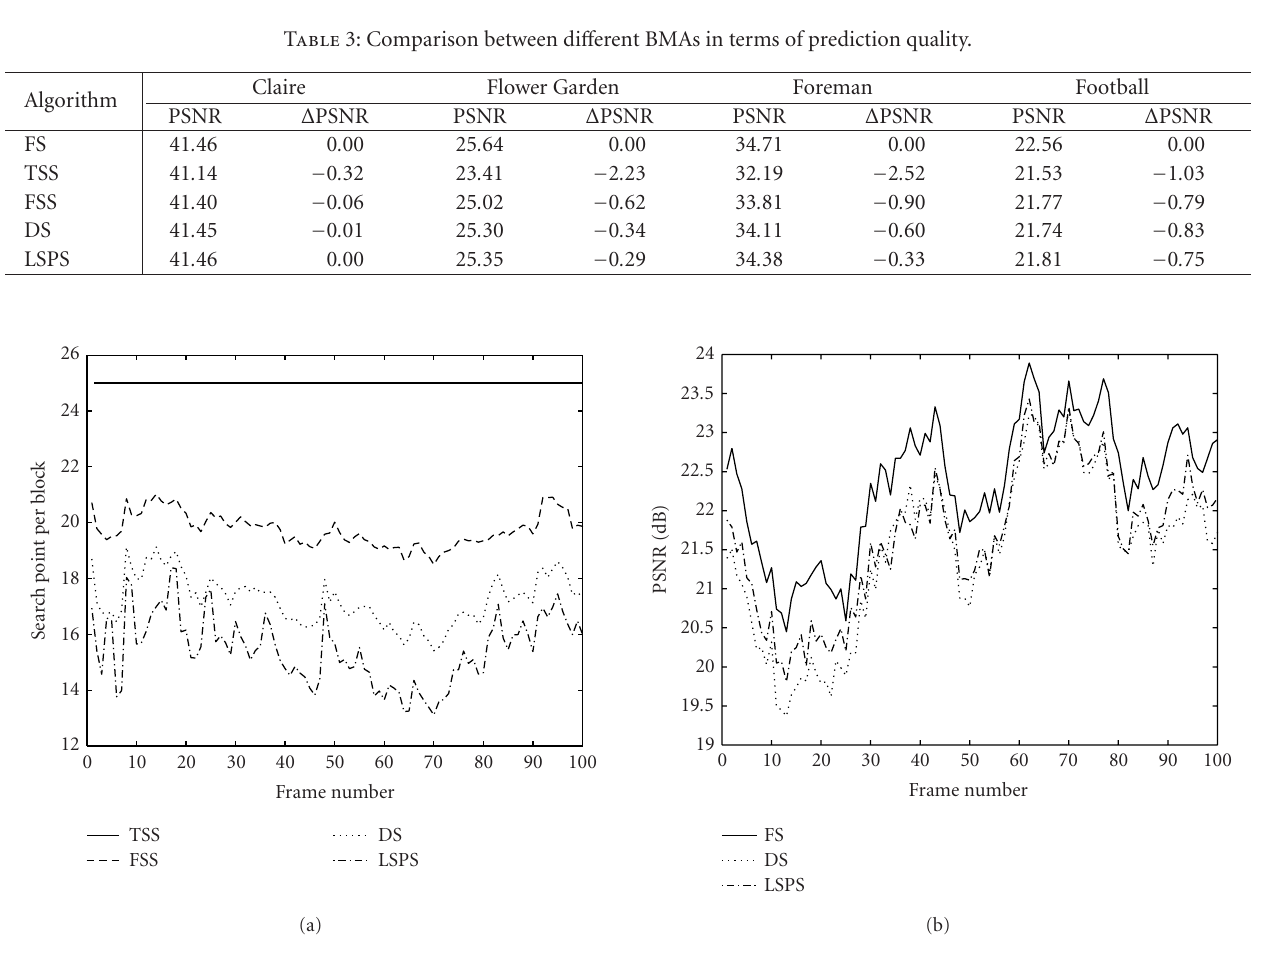
Figure 5: Performance comparison between di ff erent BMAs when applied to 100 frames of the Football sequence: (a) computational com- plexity and (b) prediction